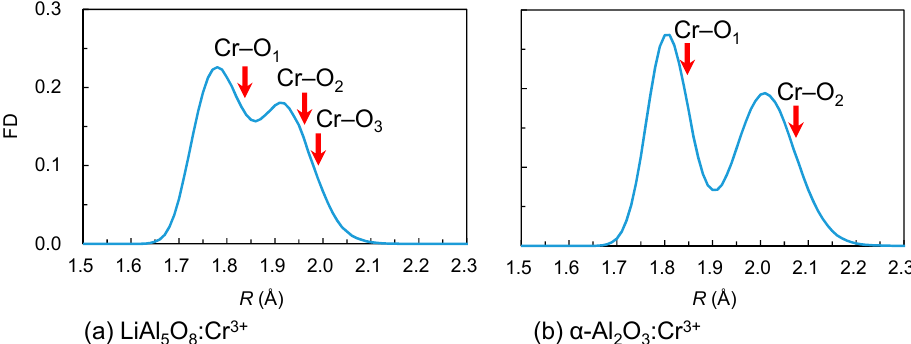
Figure 1. Frequency distributions of O atoms around Al for ( a ) LiAl 5 O 8 :Cr 3+ and ( b ) α -Al 2 O 3 :Cr 3+ . The arrows indicate the Cr–O distances obtained by MD.